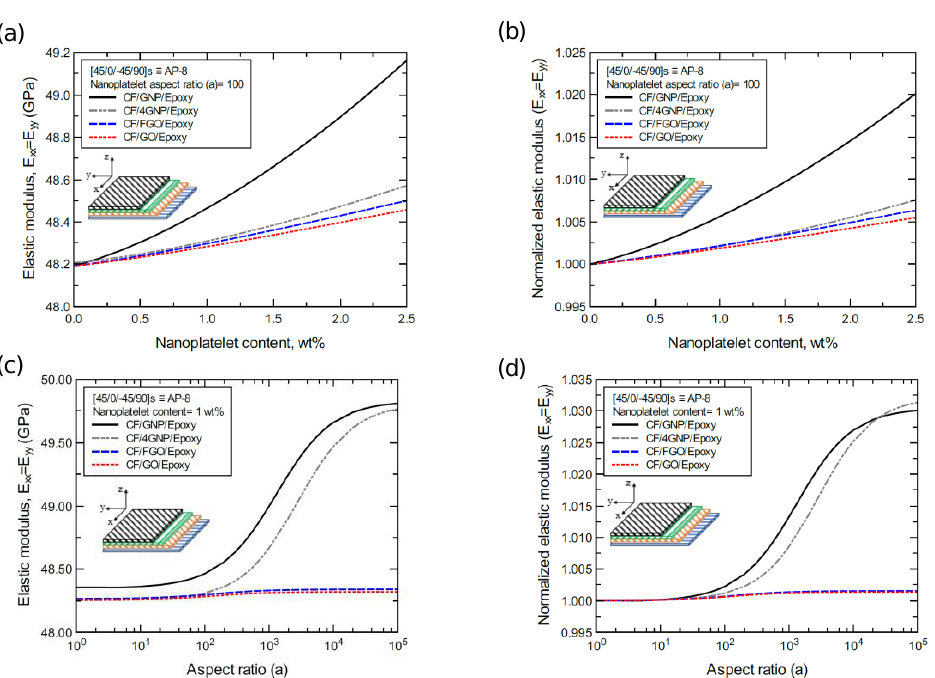
Figure 19. Comparison of the predicted in-plane elastic modulus (E xx = E yy ) for a [45/0/-45/90]s (AP-8)-laminated composite plate based on the nanoplatelet type, content, and aspect ratio; ( a ) predicted E xx for various nanoplatelet contents at 100 aspect ratio, and the normalized response is shown in ( b ); ( c ) predicted E xx for various aspect ratio values at 1.0 wt% nanoplatelet content, and the normalized response is shown in ( d ). The volume fraction of CF is 56%.